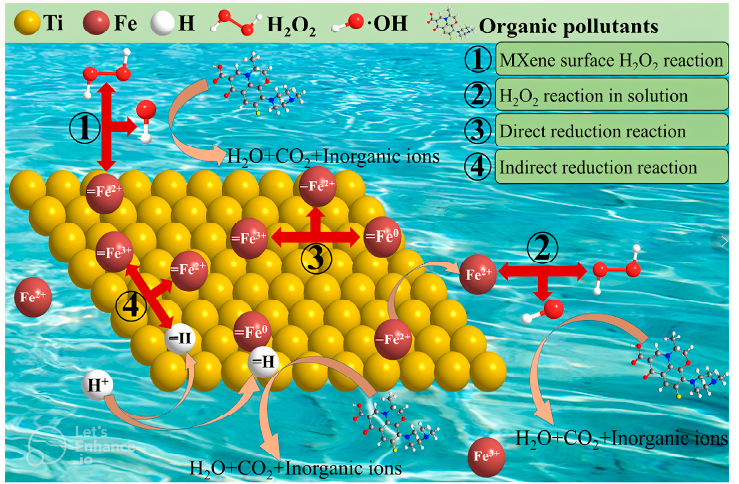
Figure 7. An investigation of the possible mechanism by which 2D MXene/H 2 O 2 can degrade organic pollutants [165].